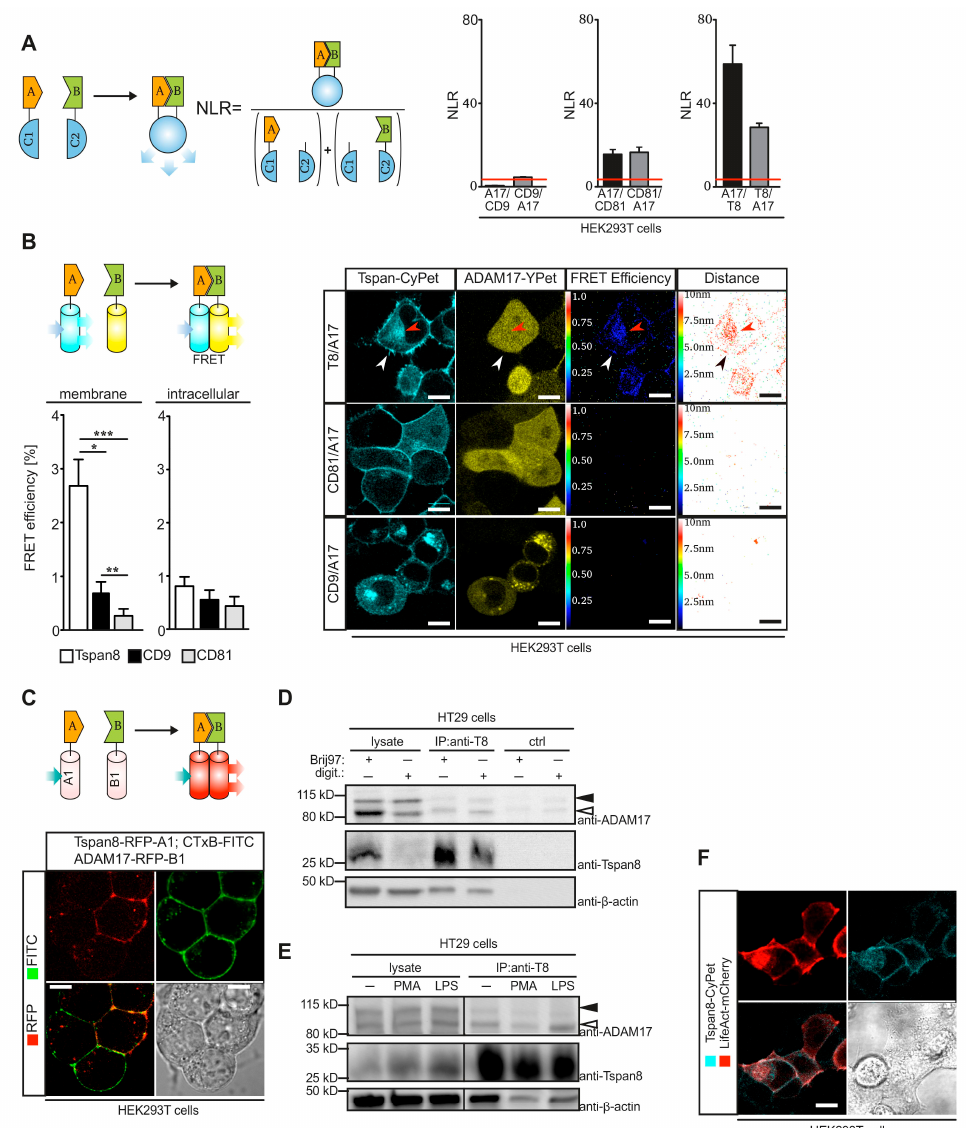
Figure 2. Tspan8 associates with ADAM17 predominantly at the plasma membrane. ( A ) Principle of split-luciferase assay. NLR denotes normalized luciferase ratio. ADAM17 specifically interacts with Tspan8 and CD81 but not with CD9 in overexpressing HEK293T cells, as assessed by split- luciferase assay. ( B ) Interaction of ADAM17 and Tspan8 can be detected at the plasma membrane and in perinuclear compartments using FRET microscopy of HEK293T cells expressing the indicated fusions of ADAM17 or Tspans with the indicated fluorescent proteins. ( C ) RFP heterodimerization assay confirms ADAM17-Tspan8 interaction at the plasma membrane in transfected HEK293T cells. ( D ) Endogenous ADAM17 co-immunoprecipitates with endogenous Tspan8 in HT29 colon carcinoma cells. digit.: digitonin ( E ) Interaction of ADAM17 with Tspan8 is independent of ADAM17 activation. HT29 were stimulated with 1 µg/mL LPS or 200 nM PMA and Tspan8 was isolated by immunoprecipitation and analyzed by SDS-PAGE for co-immunoprecipitating ADAM17. ( F ) Overexpression of CyPet-fused Tspan8 and mCherry-fused β -actin (LifeAct-mCherry) confirms co-localization of actin filaments and Tspan8 at the plasma membrane. Black filled arrow heads: ADAM17, pro-form, black open arrow heads: ADAM17 mature form. Data are represented as mean ± s.e.m. n = 3 independent experiments ( A , B ), * p < 0.05, ** p < 0.01, *** p < 0.001, Kruskal–Wallis with Dunn’s post-hoc test ( B ).